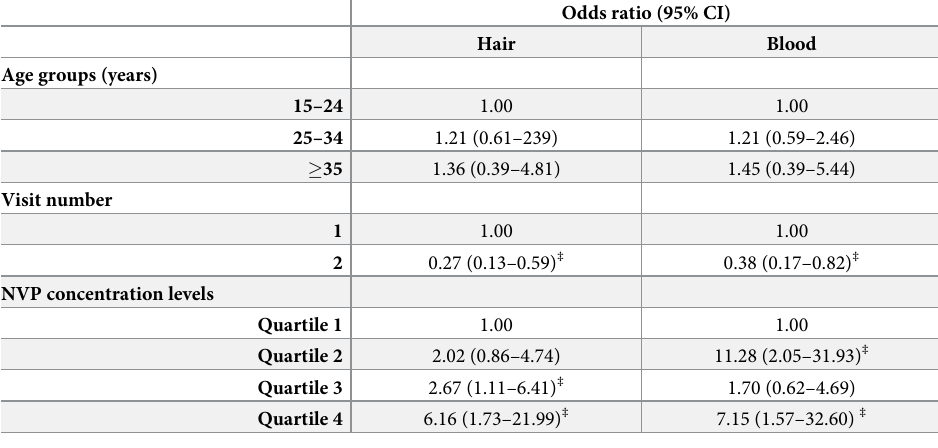
Table 3. Odds ratio (95% confidence interval) for the association of NVP hair and blood concentration with viral load < 1000 copies/mL (for all person-visits).